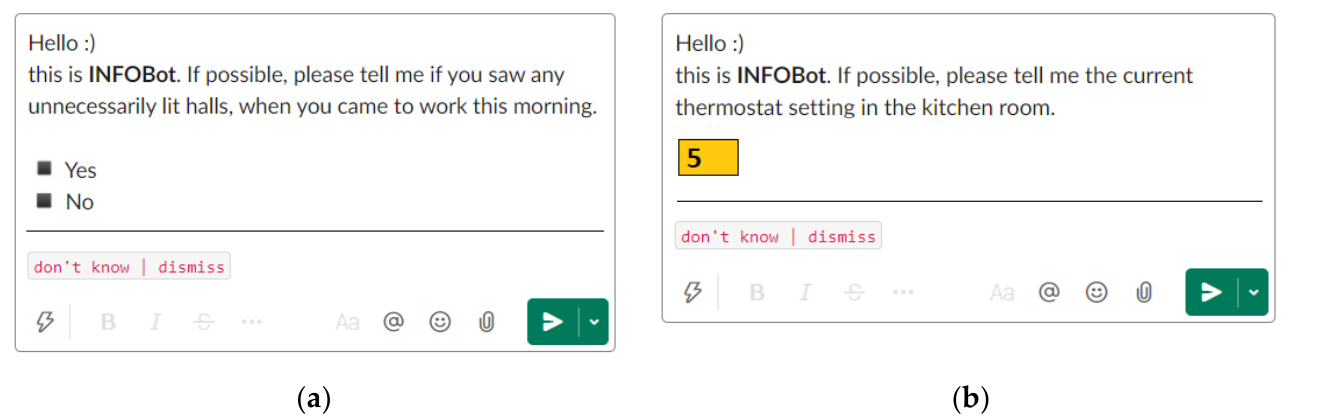
Figure 1. Possible rendering of sensing requests, as presented to a user: ( a ) a closed-ended question and ( b ) a question about a number; based on Slack [10].